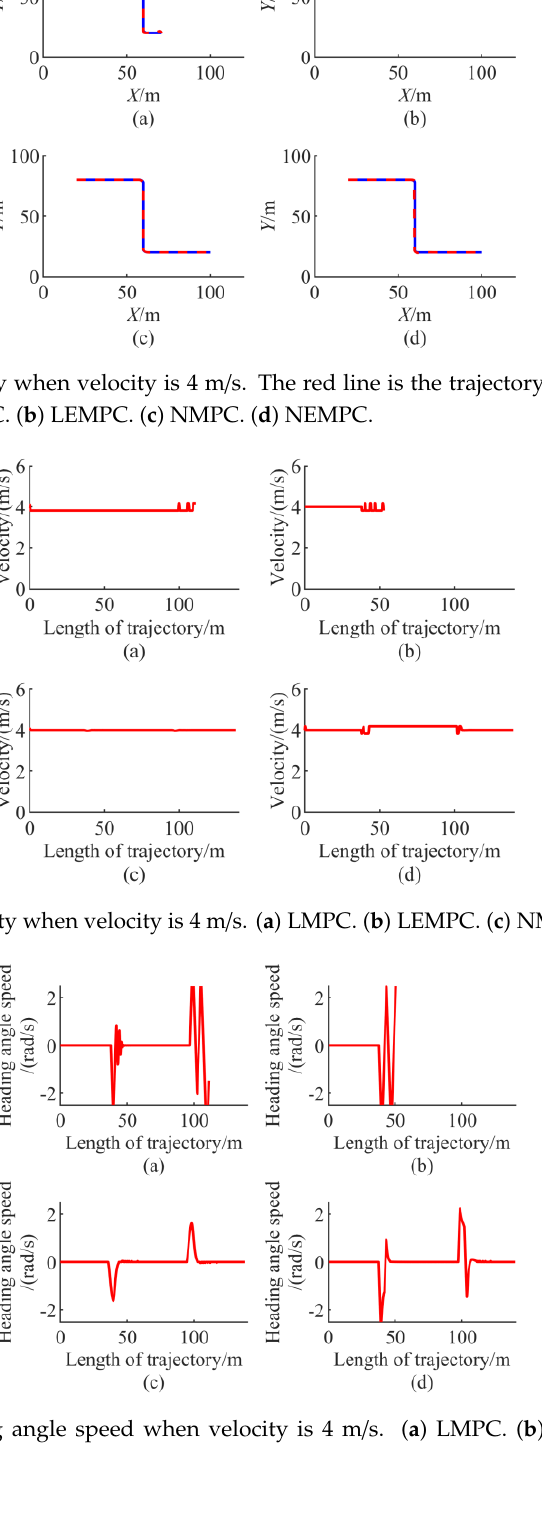
Figure 16. The displacement error when velocity is 4 m/s. ( a ) LMPC. ( b ) LEMPC. ( c ) NMPC. ( d ) NEMPC.